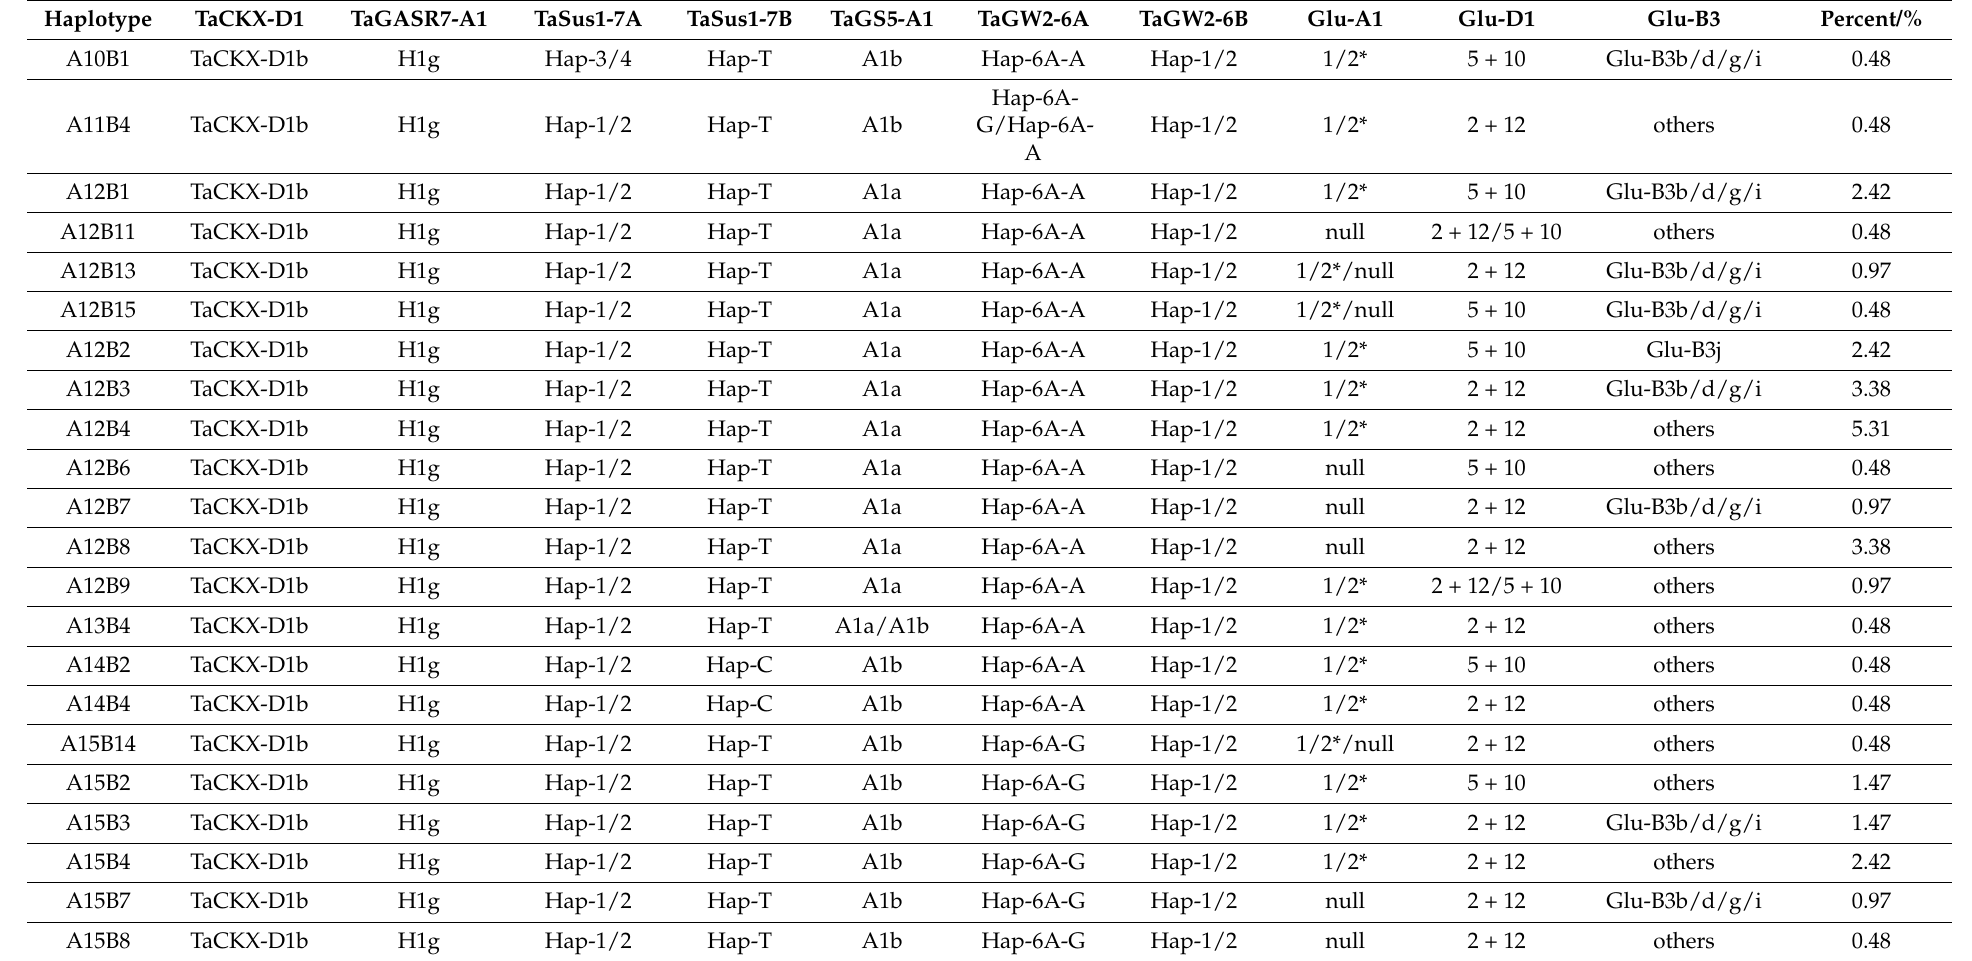
Table 2. The allelic combinations for grain yield (A, 23 combinations) and protein content (B, 15